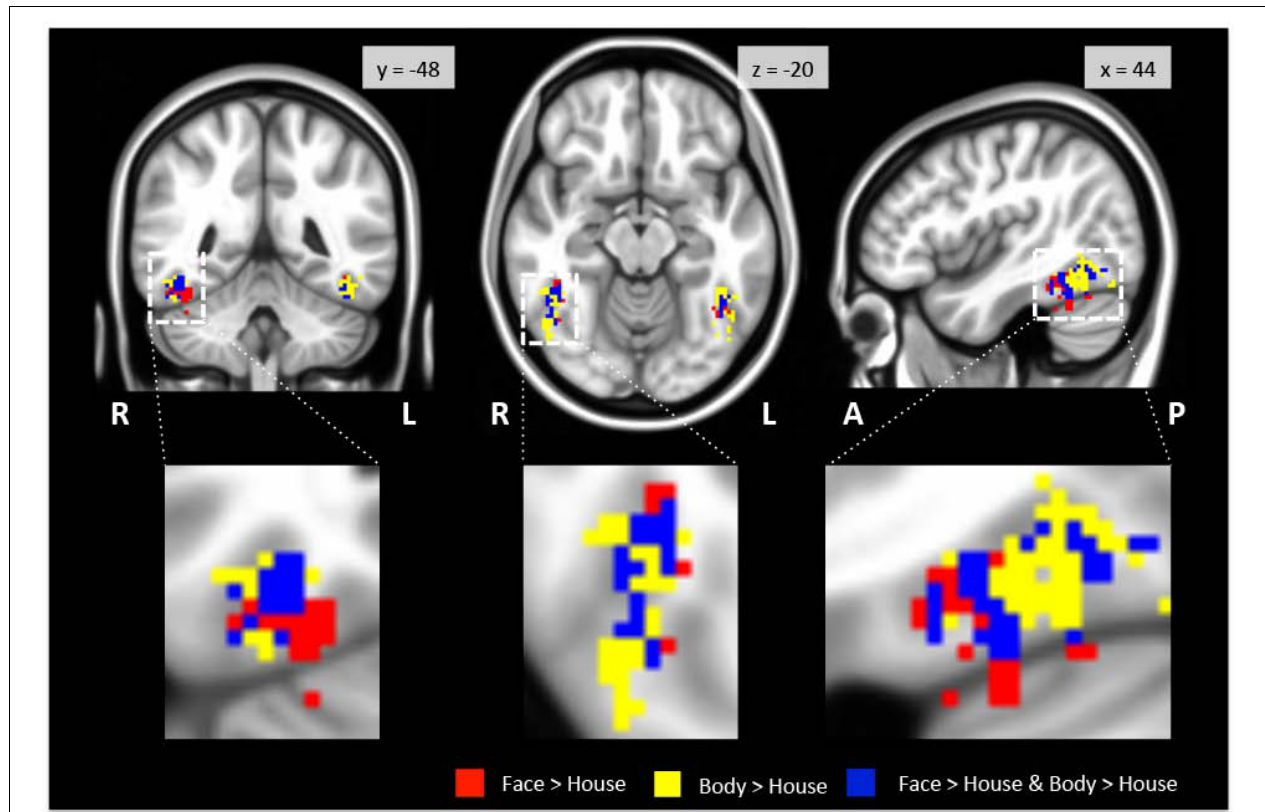
FIGURE 2 | Regions activated in group-level GLM analysis within the TOFC ROI. Faces (red) and bodies (yellow) evoked substantially overlapping activations when compared to houses (see Table 2 for the overall volumes of activations). The blue overlay indicates the overlap